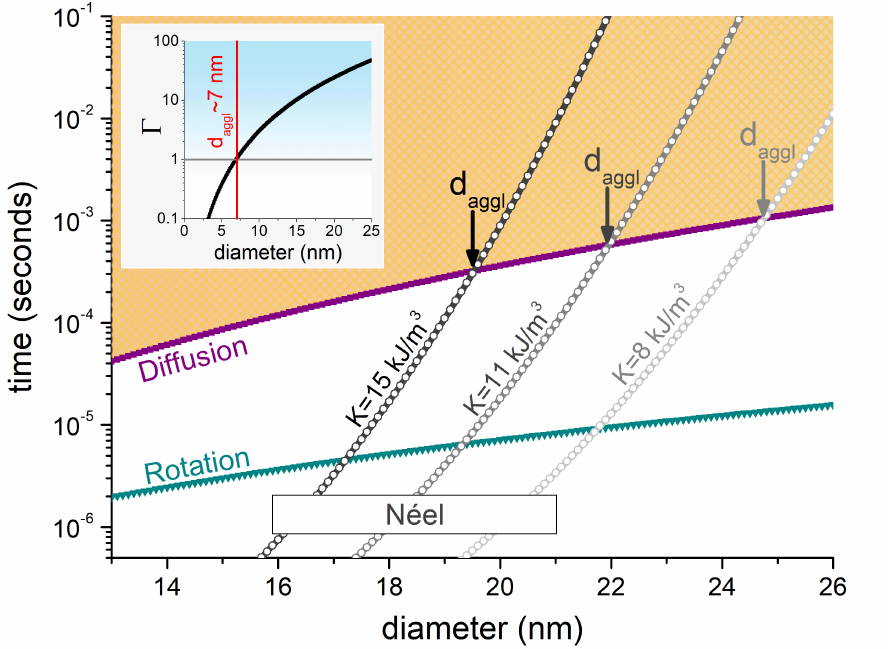
Figure 1. Diffusion ( τ dif f ; purple line), rotation ( τ B ; green line), and Néel relaxation time ( τ N ; grey lines), as a function of the particle diameter. The distinct τ N curves correspond to the different K values indicated. The dashed light-orange area indicates the range where agglomeration can be expected. The inset shows the size dependence of the Γ , which predicts agglomeration for sizes d > 7